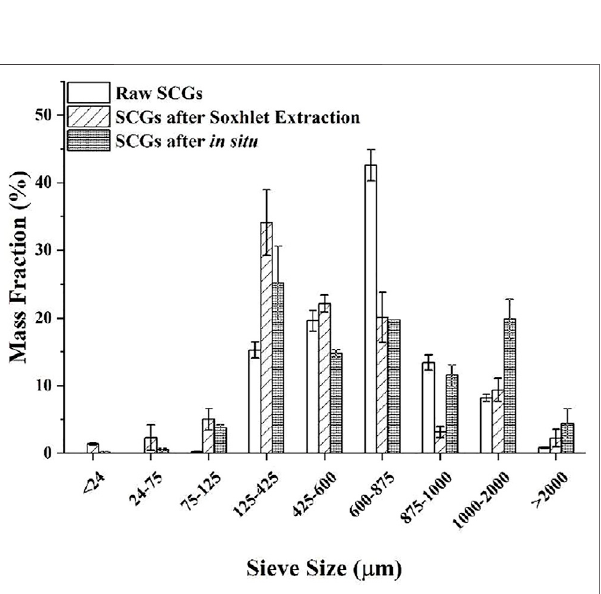
FIGURE 2 | Size distribution of different SCGs, raw and